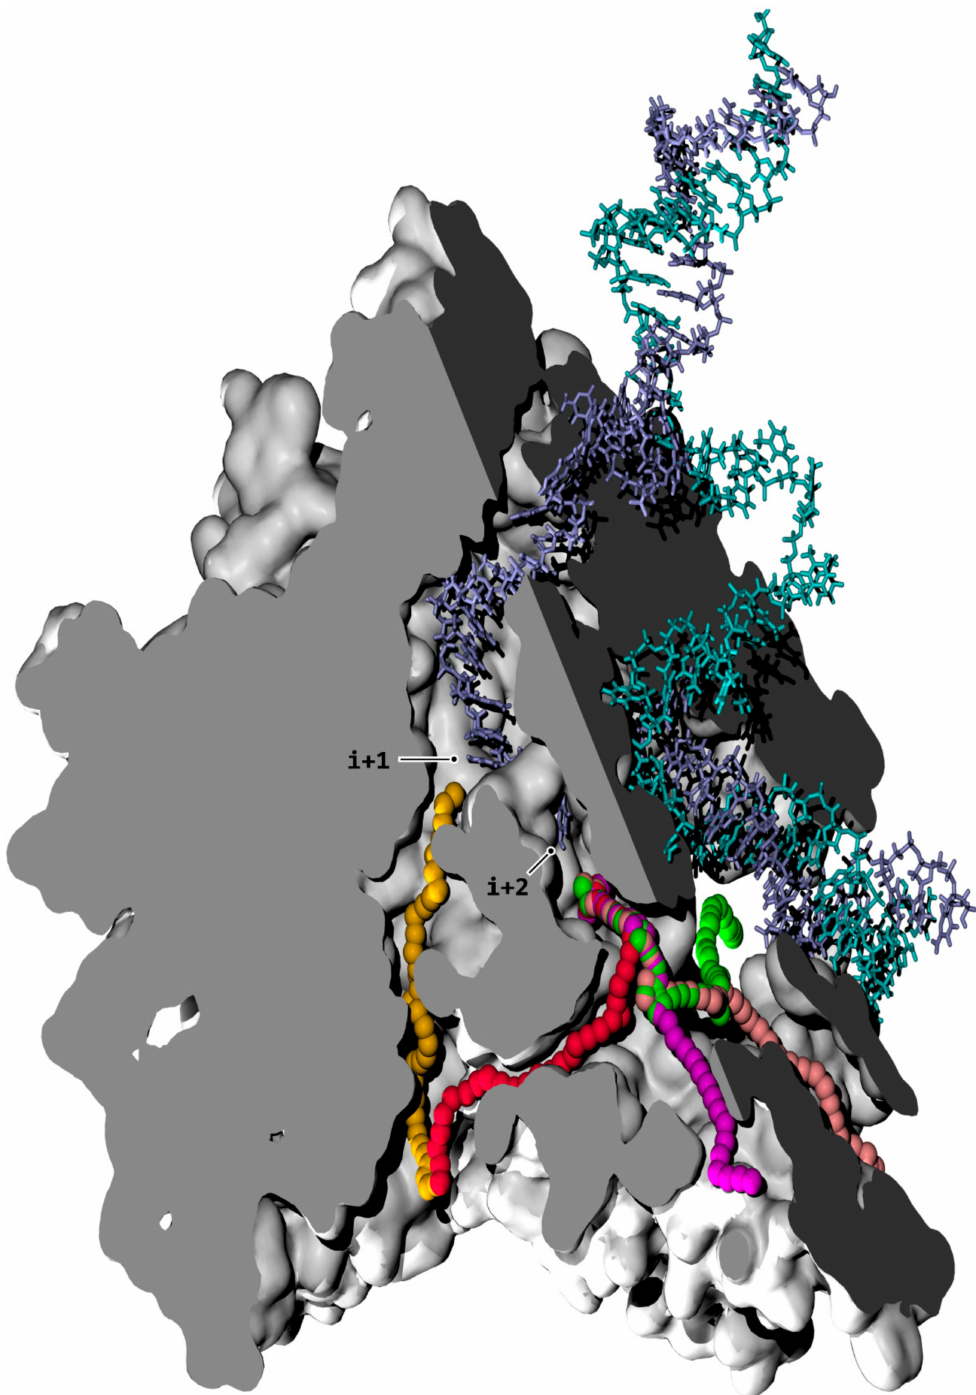
Figure 1. Nucleoside triphosphate (NTP) pathways in RNAPII. The cutaway view through the enzymatic complex is rendered via two cuto ff planes (light and dark grey solid fills). The displayed conformation is from simulation aMD_A1 (simulation indexes are listed in Table 1). The protein walls are represented as white surfaces. The template and non-template DNA strands are fully shown, in fade blue and cyan stick representation, respectively. The pathway axes verifying maximal distance from protein interlining atoms for secondary channel (CH2) (orange), CH3A (red), CH3B (magenta), CH3C (pink), and CH3D (green) subchannels are shown as a series of balls. The latter trajectories are generated with a custom-built pathway-exploration algorithm. The CH2 trajectory leads to the i + 1 register, whereas the CH3A / B / C / D paths lead to the i + 2